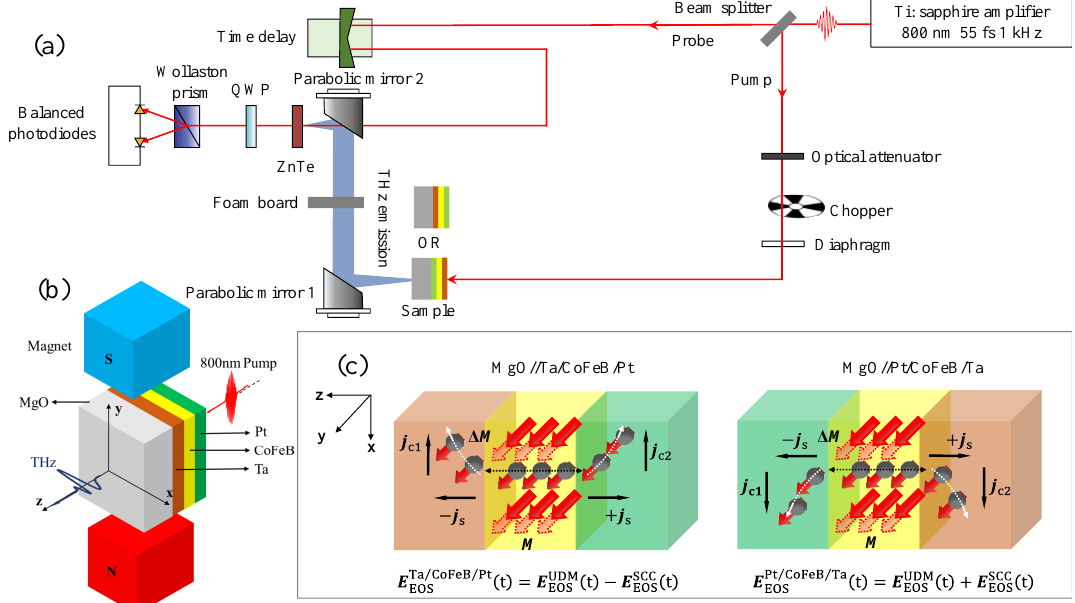
Figure 1. Generation of THz radiation from trilayer MgO//Pt/CoFeB/Ta and MgO//Ta/CoFeB/Pt stacks. ( a ) Schematic geometry for the THz emission spectroscopy in the transmission configuration. ( b ) The trilayer structure is excited by an 800 nm fs pump pulse and applied in-plane magnetic field of ±200 mT. ( c ) Physical origins of SCC- and UDM-based THz generations. The black circles with arrows show the electrons with spins. The light red arrow and solid red arrow represent the magnetization M of the CoFeB layer, before and after ultrafast demagnetization, respectively. The black dotted arrows represent the diffusion of spin currents toward the Ta or Pt layer. The white dotted arrows represent the deflection and conversion of spin currents ± j s into charge currents j c in both the Pt and Ta layers.